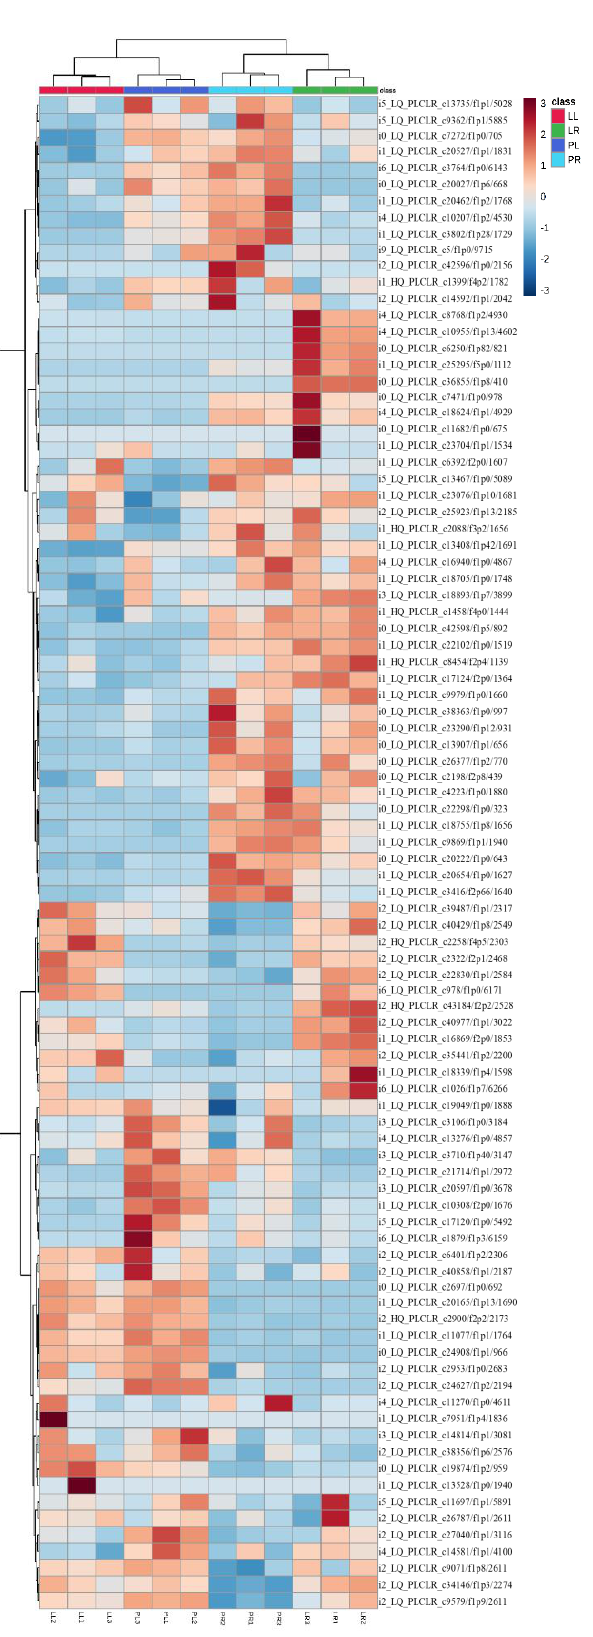
Figure 9. A hierarchically clustered heat map showing the log10 transformed gene expression values in the pathway of “biosynthesis of unsaturated fatty acids” from leaves (L) and roots (R) two purslane ( Portulaca oleracea ) genotypes (“Pakistan” local (“P”) and “Liaoning, China” local (“L”)). Red indicates higher expression, and blue indicates lower expression.